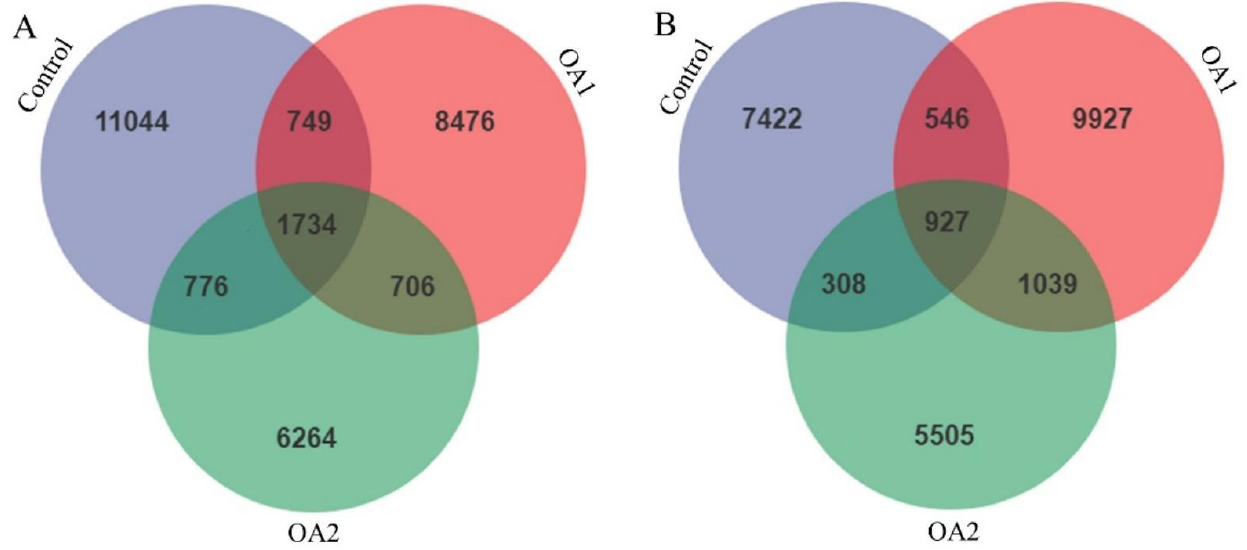
Figure 3. Number of identified ASVs in various comparisons in cecum chyme at day 14 ( A ) and day 49 ( B ). Each ellipse represents a treatment; the numbers in the diagrams represent how many ASVs are unique in the three groups and how many are shared as the areas intersect. ASVs, amplicon sequence variants.